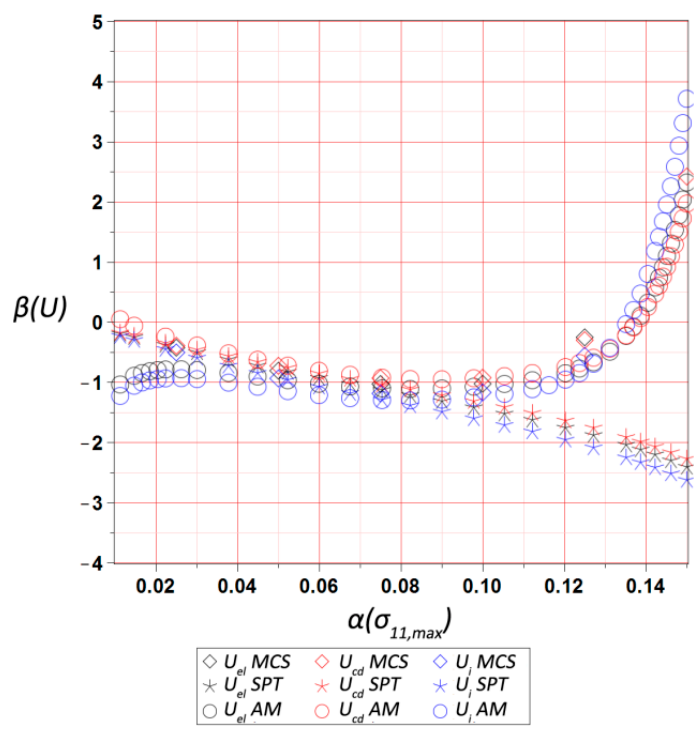
Figure 11. Skewness of the ultimate elastic strain 𝑈 𝑒𝑙 , dissipation 𝑈 𝑐𝑑 , and internal 𝑈 𝑖 energies in the RVE vs. 𝛼(𝜎 11,𝑚𝑎𝑥 ) .